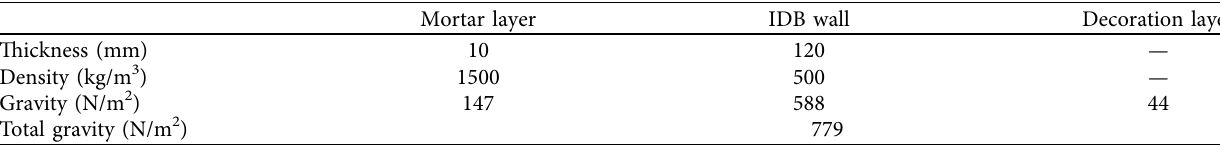
Table 6: Gravity of IDB wall insulation system.